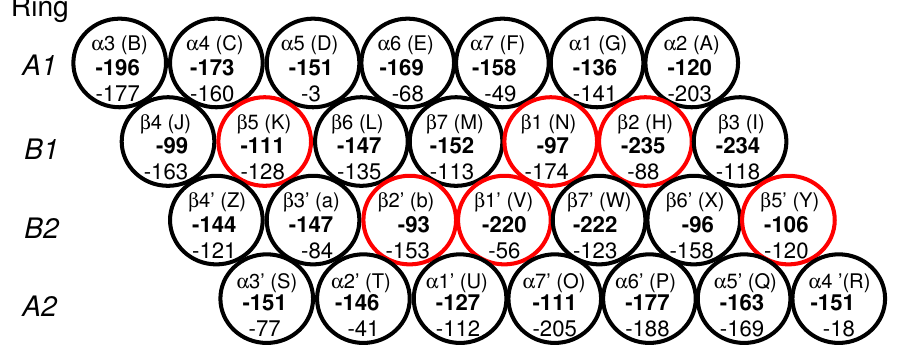
Figure 6. The diagram shows the arrangement of the 28 subunits within the four heptameric rings, A 1 , B 1 , B 2 , and A 2 , of the CP of the 20S proteasome. The subunits containing proteolytic active